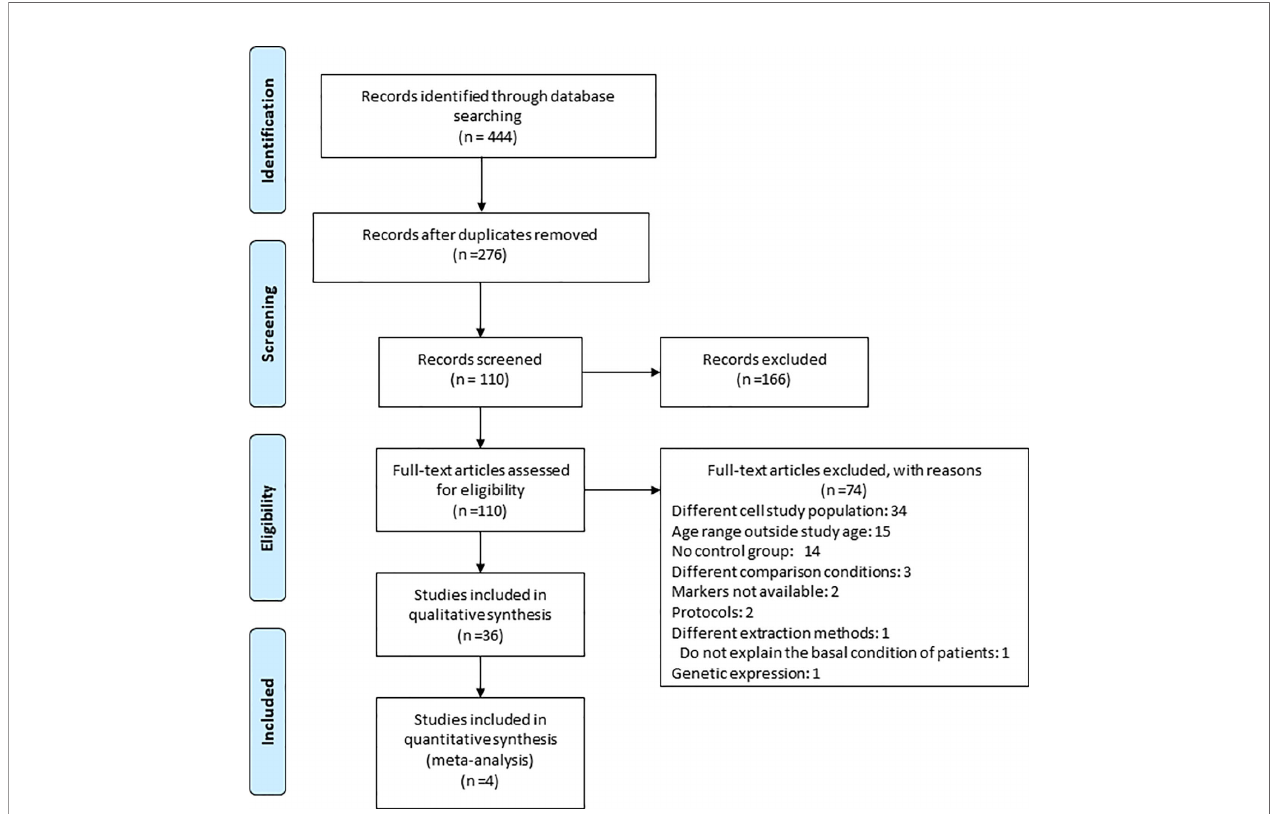
FIGURE 1 | Study fl ow diagram. The search strategy performed in this article led to the initial selection of 418 potential papers. 303 were retrieved from PUBMED/ MEDLINE, 115 from EBSCO and 0 from BVS in the identi fi cation phase. After duplicates were removed, a total of 263 papers were identi fi ed. From these, 157 articles were excluded based on title and abstract. Further investigation of the remaining 106 full text articles led to the exclusion of 70 articles and the inclusion of 36 studies for the qualitative synthesis among which 4 studies allowed us to perform a